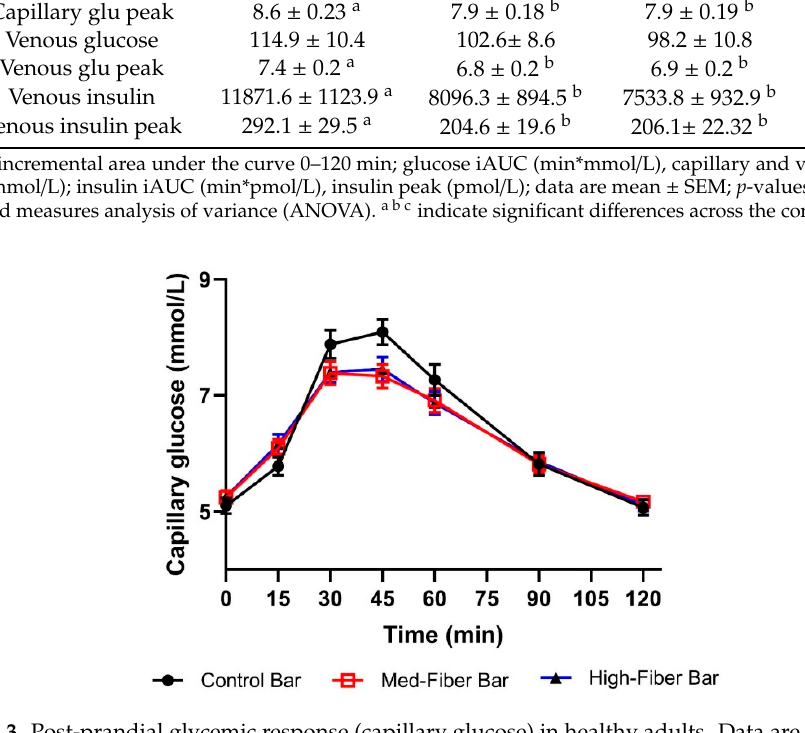
Table 4. Incremental area-under-curve (iAUC) and peak values for glucose and insulin.